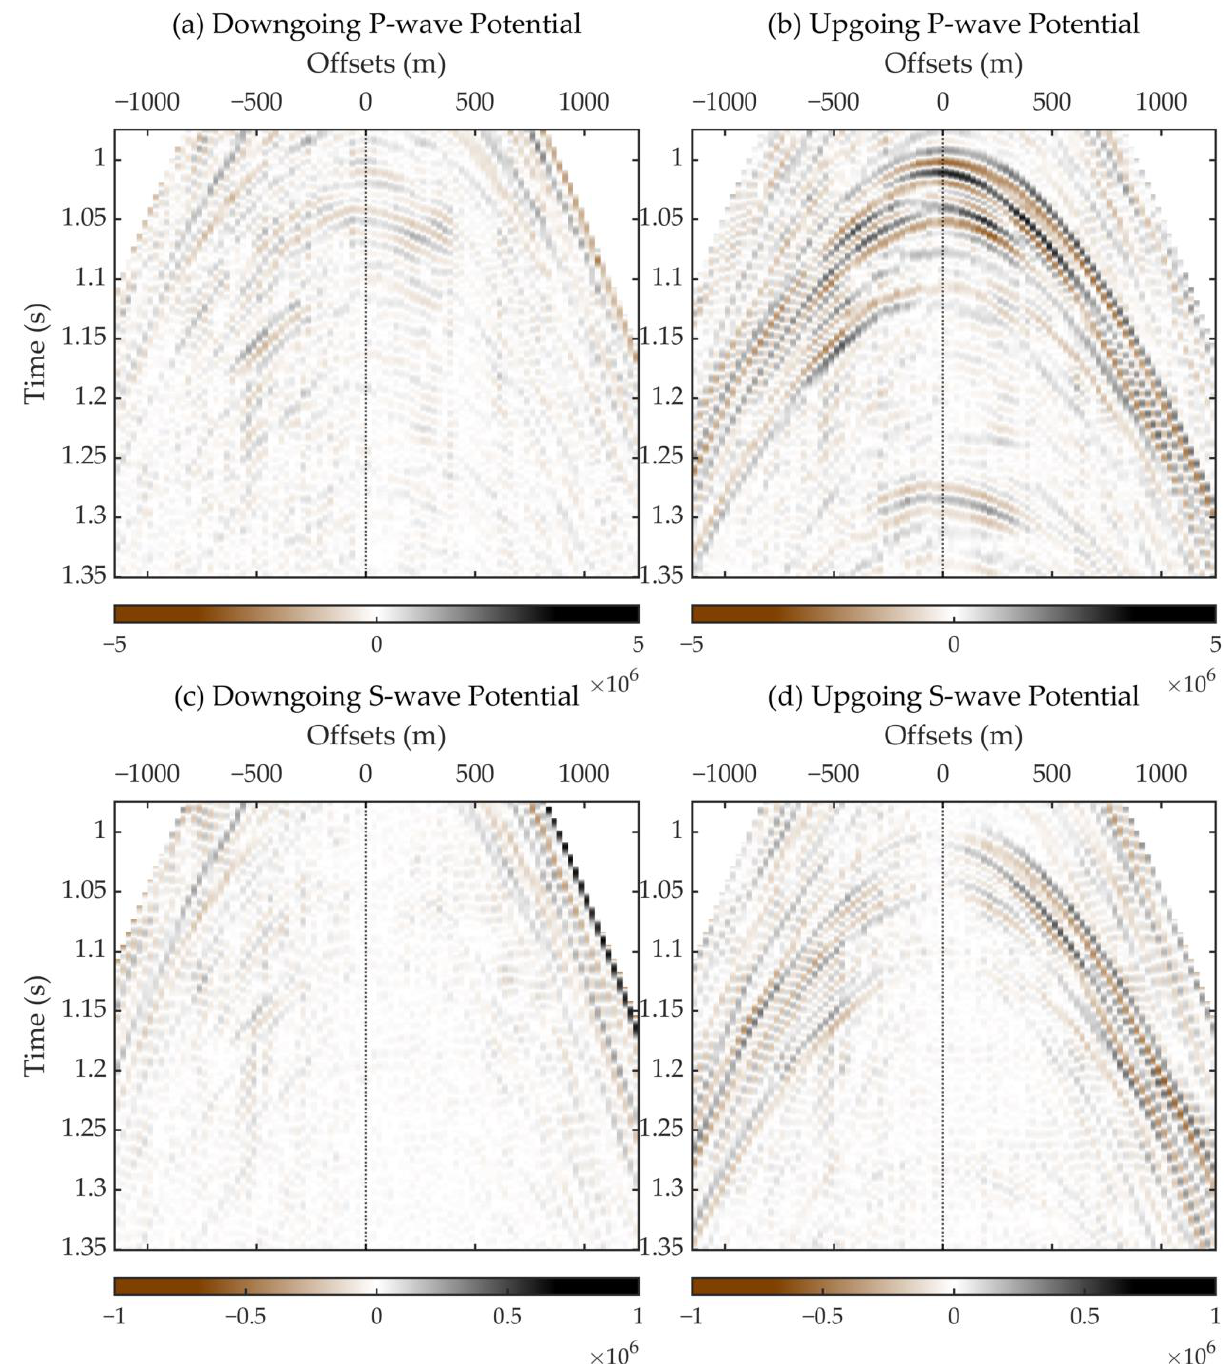
Figure 16. Enlarged views of the ( a ) downgoing P-potential, ( b ) upgoing P-potential, ( c ) downgoing S-potential, and ( d ) upgoing S-potential decomposed just below the seafloor (mostly focused on the area containing primary events).